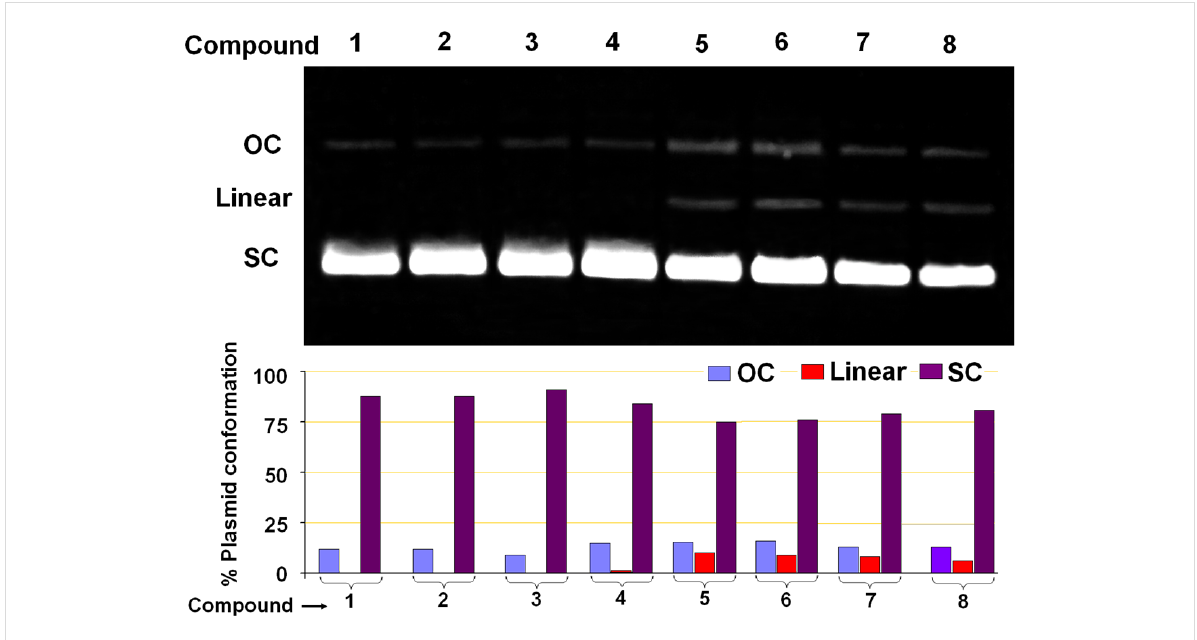
Figure 1: Nuclease activities of the triptycene derivatives 1–8 . Agarose gel (top) shows results of the incubation of pUC19 plasmid DNA with trip- tycene derivatives and the bar diagram (bottom) represents the quantitative analysis of the gel bands. This shows the amount of different forms of plasmid present after incubation with the compounds. OC and SC represent the open circular and the supercoiled form of the plasmid, respectively.